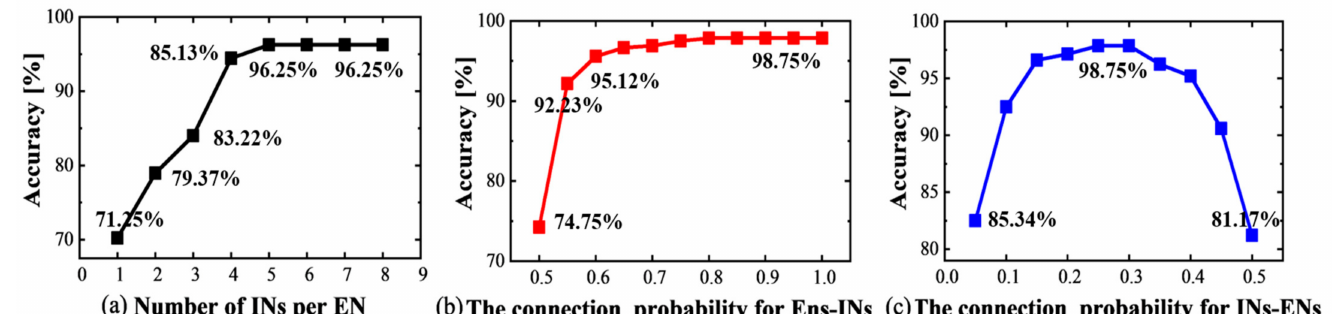
Figure 5. ( a ) The overall accuracy for various numbers of INs (Inhibitory Neurons) for each EN (Excitatory Neuron); ( b ) The overall accuracy for different connection probabilities for ENs-INs; ( c ) The overall accuracy for the different connection probabilities for